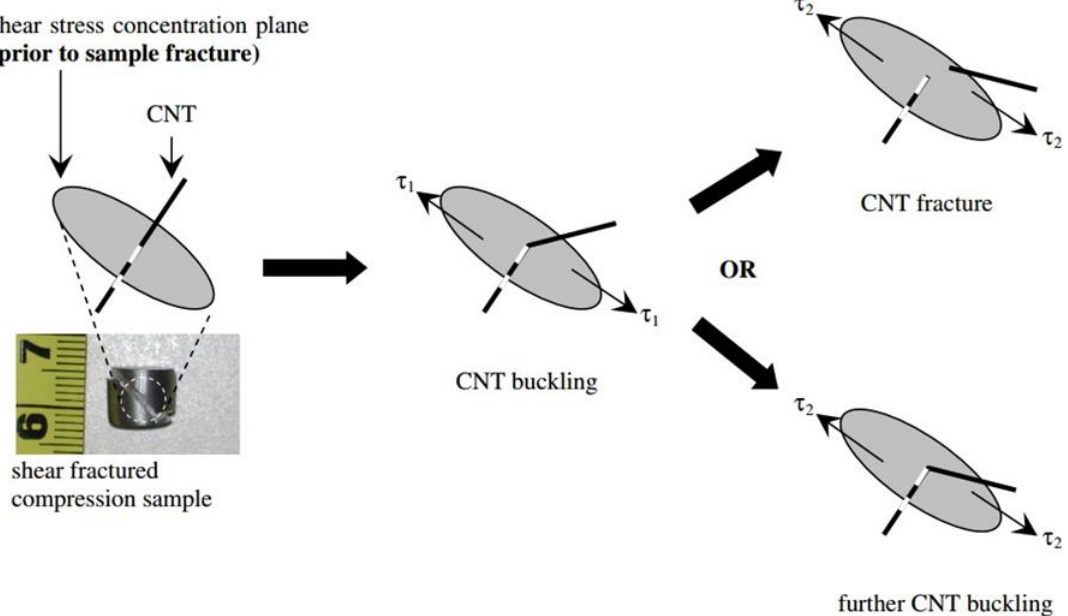
Figure 6. Compressive shearing and buckling of CNTs in ZK60A-based nano-composite ( τ 2 , τ 1 are in-plane stresses of shear nature, where τ 2 > τ 1 ) [105].